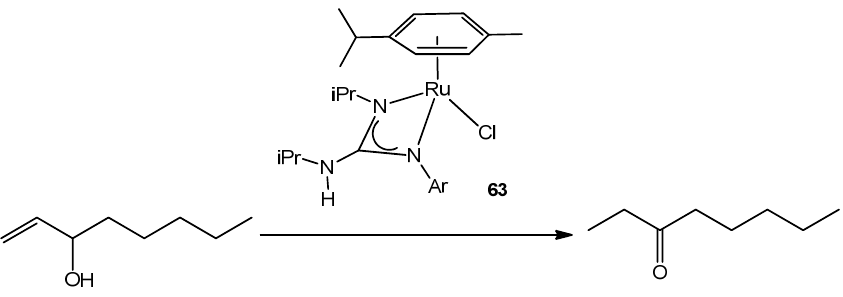
Figure 37. Ruthenium guanidinato complex acting as catalyst for allylic alcohol isomerization.